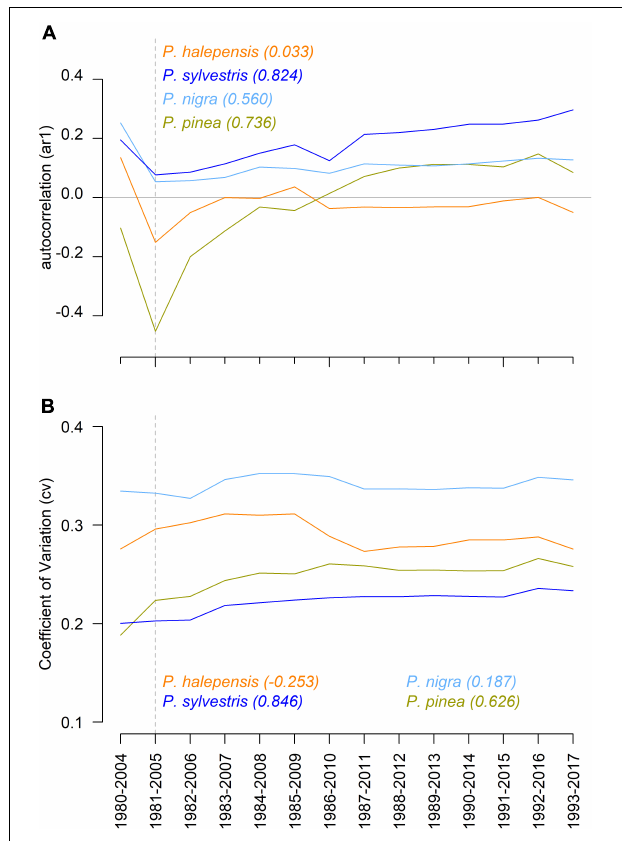
FIGURE 6 | Early warning signals of drought-induced growth decline for each pine species. The first order autocorrelation (A) and the coefficient of variation (B) in the chronology of each species were calculated using 25-year moving windows for the period 1980–2017. Different colors correspond to each species and the number in parenthesis indicate the non-parametric Kendall tau correlation for the statistic of each species. The dashed line indicates the 2005